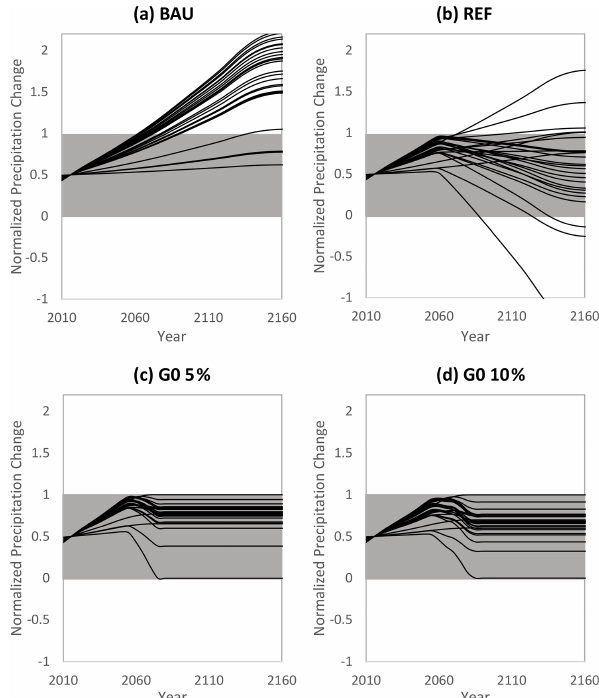
Figure 3. Normalized precipitation change. (a) No policy (“BAU”); (b) 2 ◦ C target activated and unlimited usage of SRM (“REF”); (c) all Giorgi regions’ precipitation guardrails being activated when the extra admissible area is 5% of the standard deviation (“G0 5%”); (d) similar to panel (c) but with 10% of the standard de- viation (“G0 10%”). For the 26 Giorgi regions and different policy scenarios, precipitation change is normalized such that “1” is the constraint which corresponds to the precipitation levels of a tem- perature anomaly of 2 ◦ C, and “0” equals the constraint which is determined by the preindustrial precipitation levels. Note that in cal- culating the normalized precipitation guardrails for G0 5% and G0 10% scenarios, the extra admissible areas are taken into account (see Sect. 2.1 for more details on the guardrails). These corridors are indicated as gray